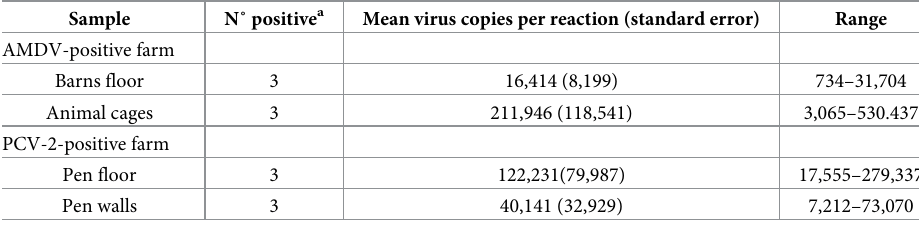
Table 3. Results of the qPCR in the environmental surface